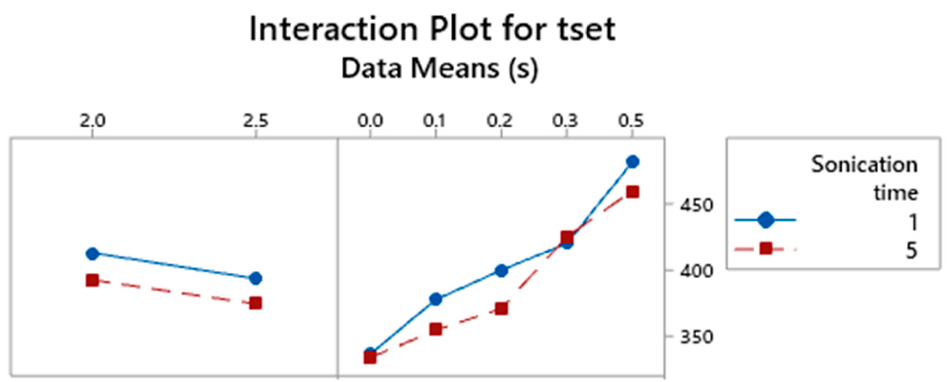
Figure 5. Interaction plot between the effect sonication time vs. BPO/solid ratio and sonication time vs. GO/liquid ratio for the variable t set .